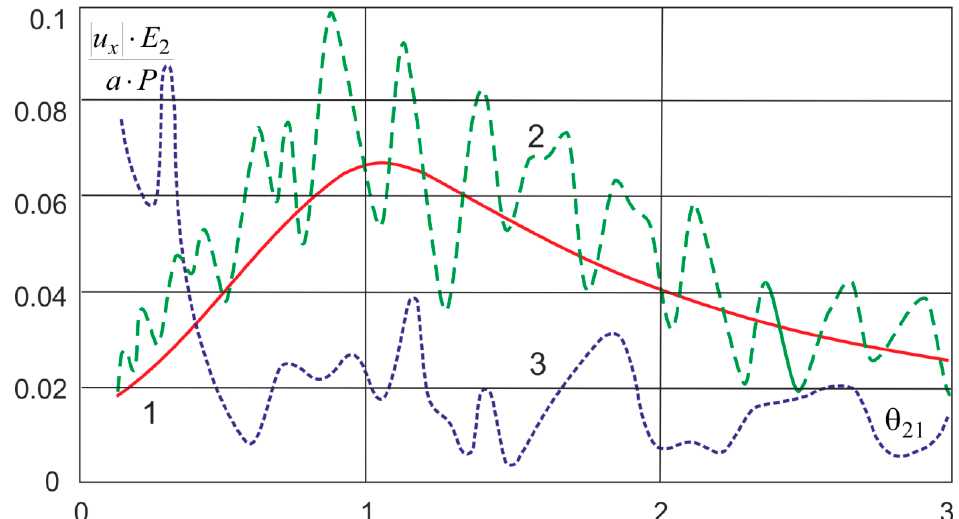
Figure 9. Dependence of the amplitude–frequency characteristics of the layered medium: 1, half-space; 2, softer near-surface layer E 4 < E 3 ; 3, harder near-surface layer E 4 > E 3 .